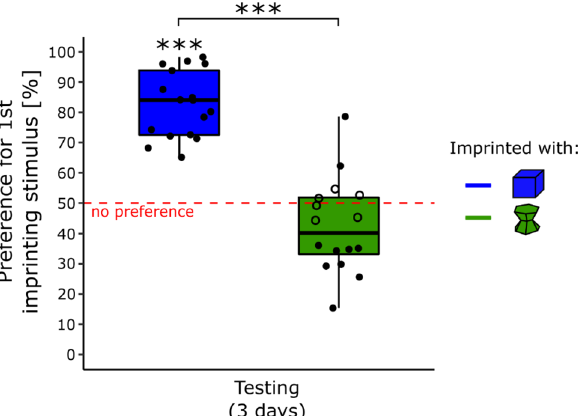
Figure 3. In experiment 3, the object used during the primary imprinting phase strongly influenced chicks’ preference for it when exposed to a novel stimulus (p < 0.001, ***). The blue boxplot represents the preference score of the chicks imprinted with the blue stimulus. The green boxplot represents the preference score of the chicks imprinted with the green stimulus. Filled dots show the individuals having a significant preference while empty dots show the individuals having no preference. The asterisks represent the overall significance of each condition, against no preference and between